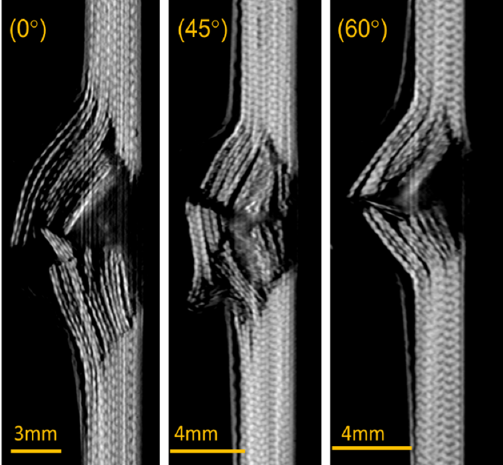
Figure 10. Cross-sectional view on the impacted region.